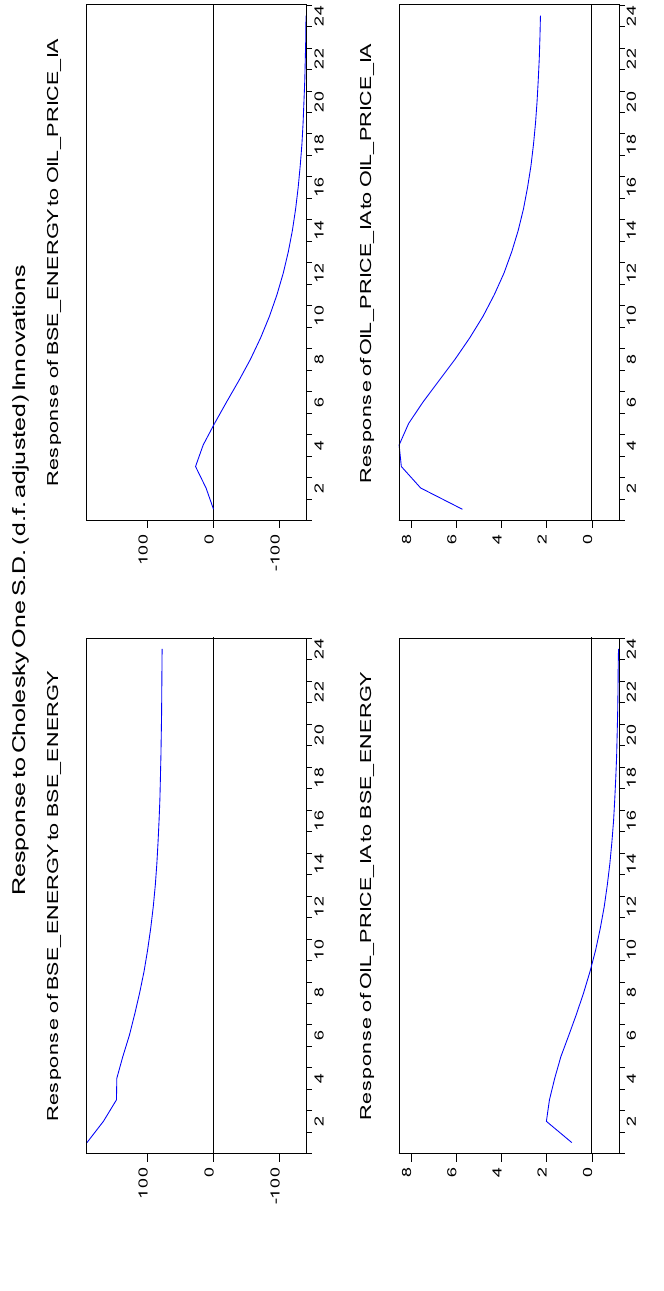
Figure 2. Impulse responses of BSE_Energy and oil price to one standard deviation shocks in the